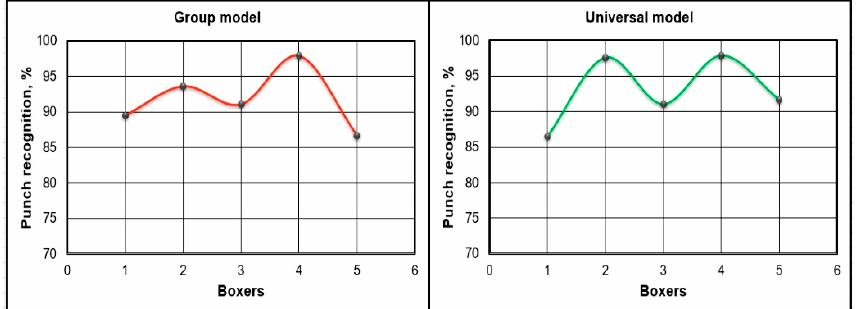
Figure 12. Graphs showing the level of recognition of punches of a group of advanced boxers (more than 5 years of training).